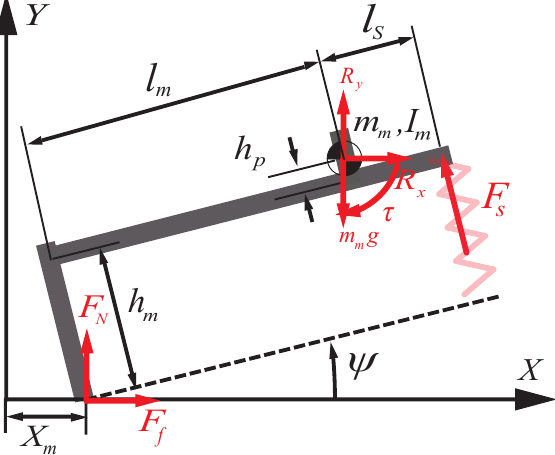
Figure 4. Tapping Robot’s free body diagram